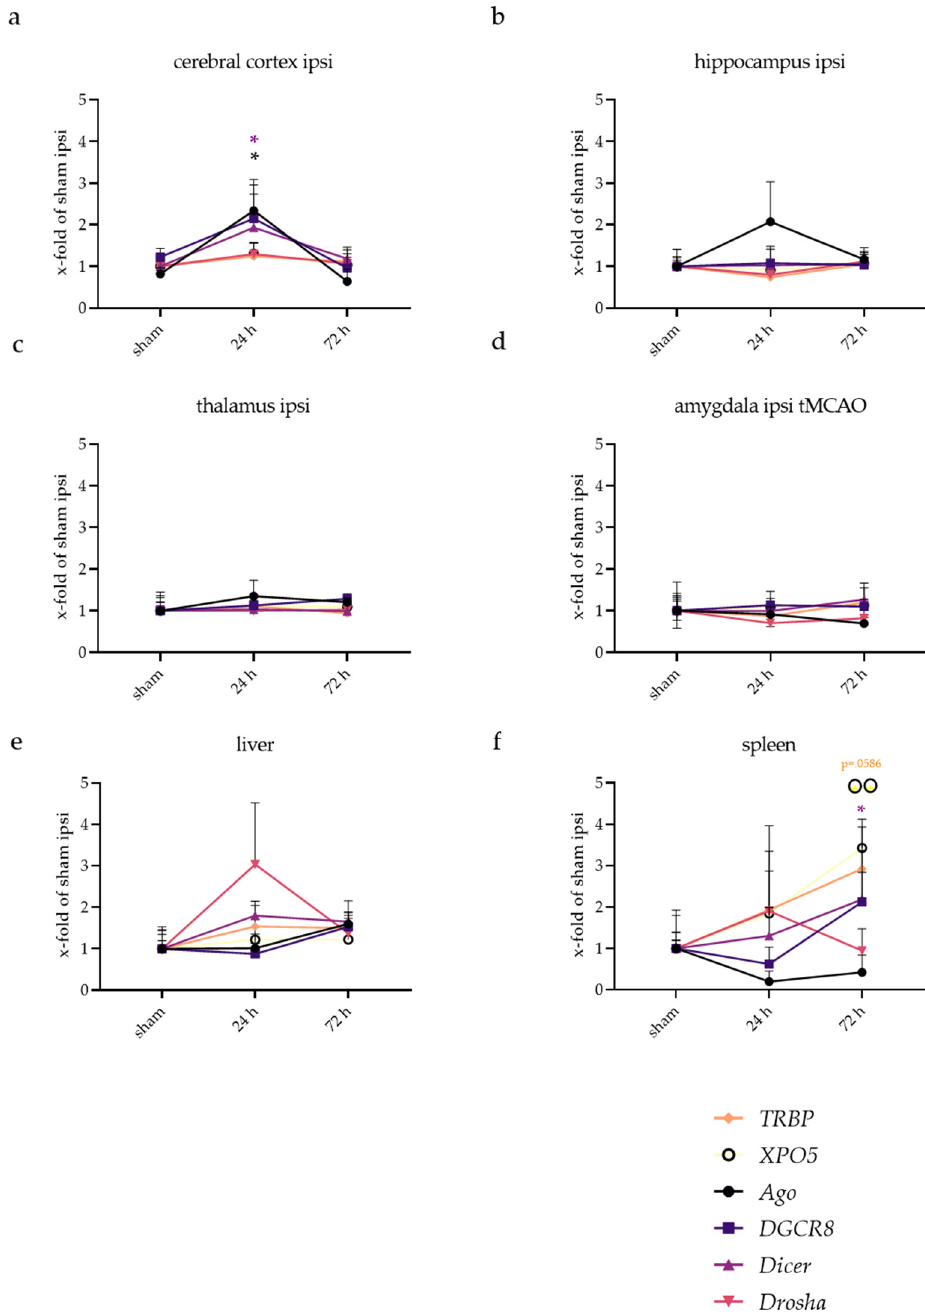
Figure A3. Expression of genes regarding miRNA maturation in different brain regions, liver, and spleen at 24 h and 72 h following tMCAo. (red) mRNA levels of Drosha , (dark purple) DGCR8 , (yellow) XPO5 , (light purple) Dicer , and (orange) TRBP in ( a ) the cerebral cortex, ( b ) amygdala, ( c ) thalamus, ( d ) hippocampus, ( e ) liver, and ( f ) spleen. (*) shows a significant difference from sham ipsi in the respective color of the gene. The statistics were performed in a group comparison with ipsi- and contralateral values. Here shown, there are just the alterations for the ipsilateral brain side.